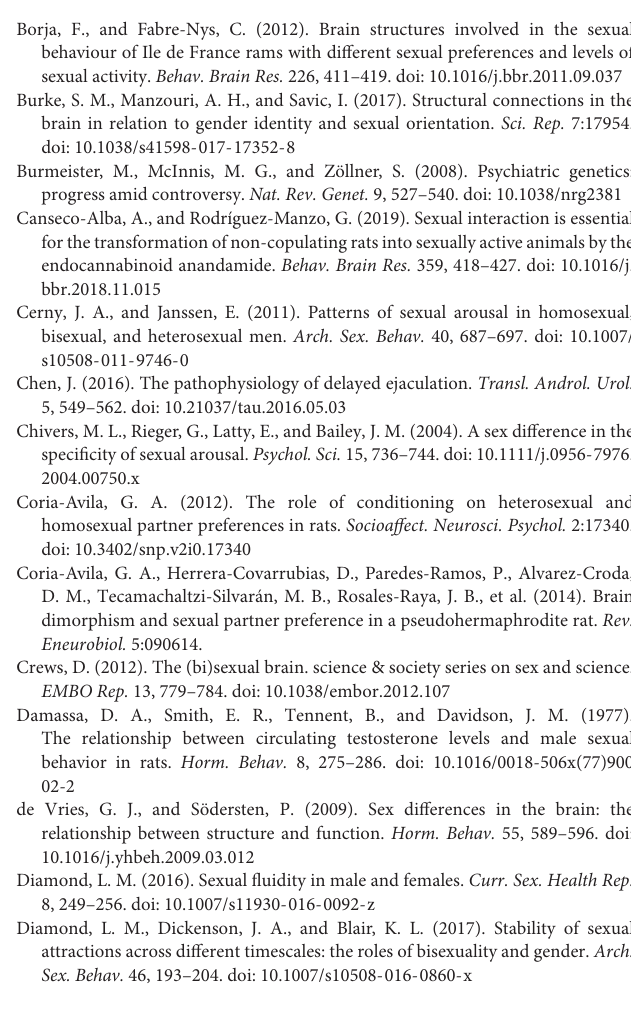
pattern of the dendrogram until reaching the tip of the tree where individual VH, H, AV, L and VL copulating males show different degrees of phenotype similarity depending upon the final location within the tree, and likely the frequency of each endophenotype across the population. In red, we show the animal clusters obtained at the cut point of 4 in height. Such clusters were used to compare the consistency of the EN-ejaculatory endophenotypes. Overall, the way copulatory parameters interact one another in most of the copulating males are more alike than distinct regardless of EN-ejaculatory endophenotype each was assigned to. (B) The combined used of a heat map and of a complete linkage dendrogram allowed us to evaluate the degree of similarity among EN-phenotyped copulating males, based on the way brain regional patterns and levels of gene expression interacted with one another per phenotyped rat across the entire population of EN-phenotyped males ( n = 20). In this figure, the heat map color-codes (blue the highest levels; see color key on the upper left corner) the relative levels of expression of AR, ESR1, CYP19, PR, DNMT1, and DNMT3a genes, clustered based upon the degree of similarity per limbic structure (see upper right corner for the color code assigned to each region in the dendrogram placed at the upper border of the heatmap) and per EN-phenotyped male (dendrogram placed at the left side of the heat map). Numerals on the right correspond to the numeric code assigned to each of the EN-phenotyped male, also color-coded based upon the endophenotype assigned [see upper right corner in panel (A) ]. Notice that gene expression clustering across the EN-phenotyped male population is ejaculatory endophenotype independent. The histogram on the upper left corner depicts the overall distribution of gene expression levels across the population of